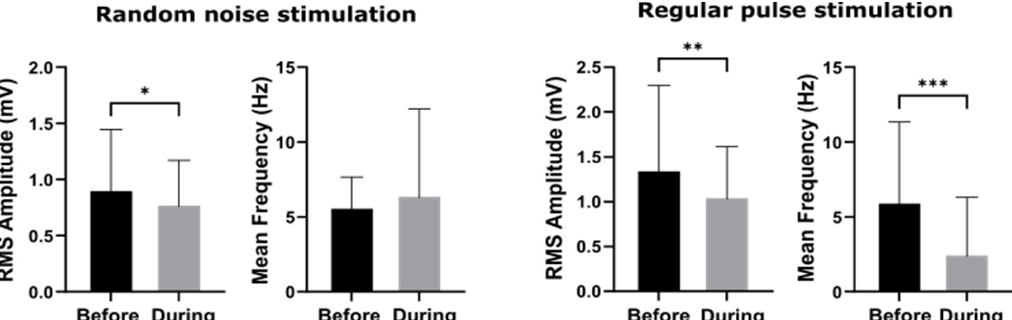
Figure 9. The group amplitude and mean frequency of EEGs before and during the two stimulation protocols, respectively. Significant difference ( p -value *: < 0.05, **: < 0.01 and ***: < 0.001) was tested by using non-parametric Wilcoxon signed-rank tests.